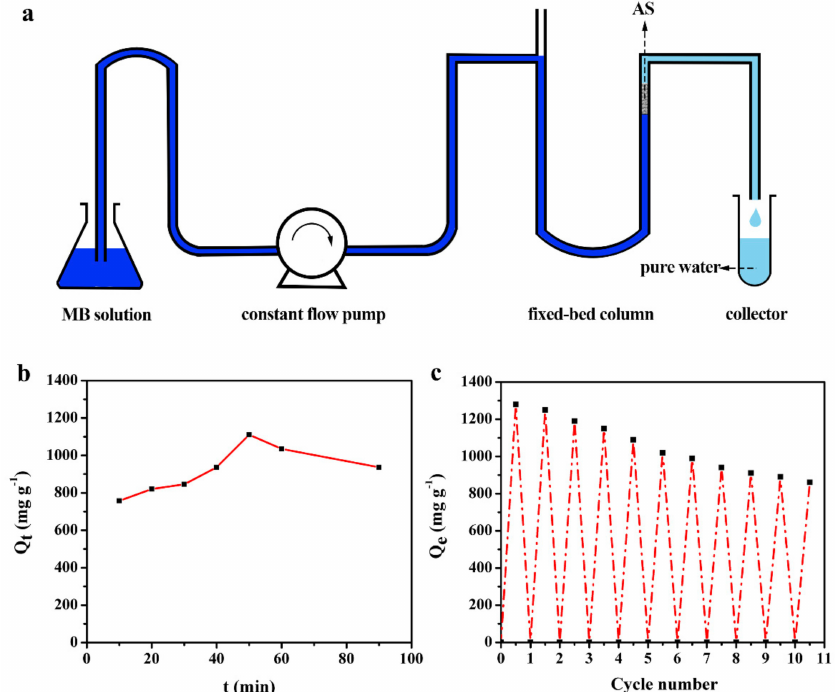
Figure 5. ( a ) The scheme of the adsorption process and equipment in the fixed-bed absorption column; ( b ) the adsorption capacities of AS with di ff erent contact time for MB removal; ( c ) the cyclic absorption capacities of AS for MB removal within 10 cycles through squeezing